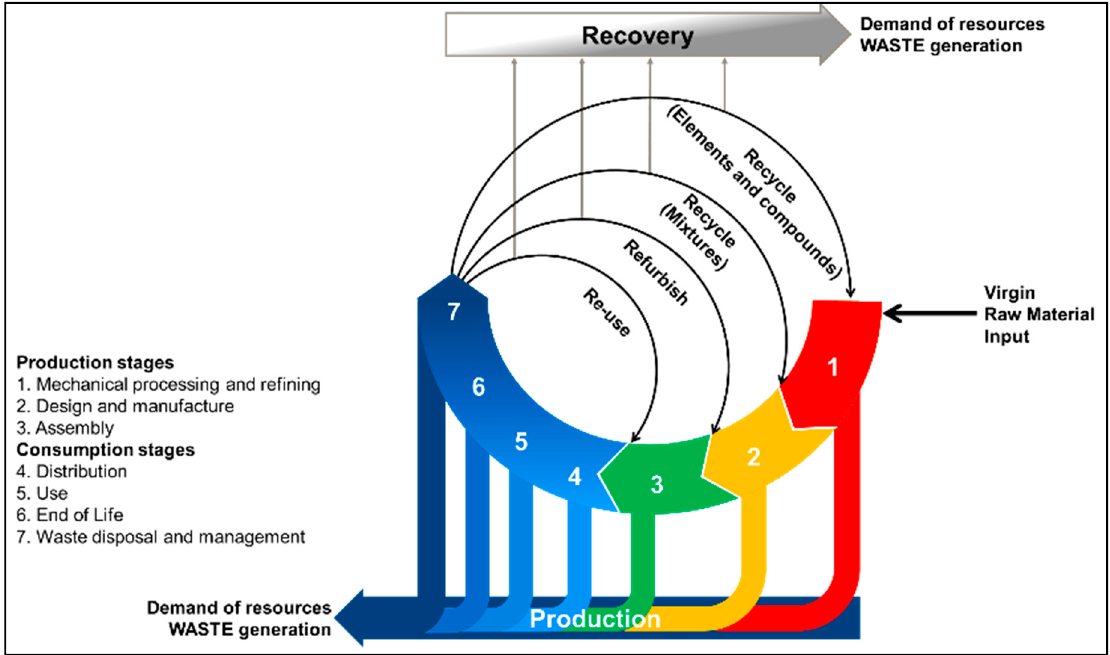
Figure 1. Circular economy model from a material-centric perspective based on Martinez et al. (2019) [32].